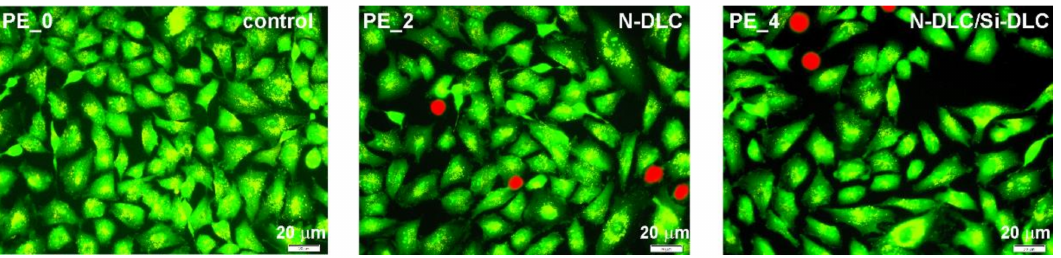
Figure 8. Live (green) and dead (red) human osteoblast-like MG-63 cells after 72 h of treatment. Cells were stained with acridine orange and propidium iodide, indicating viable and dead necrotic or late apoptotic cells,